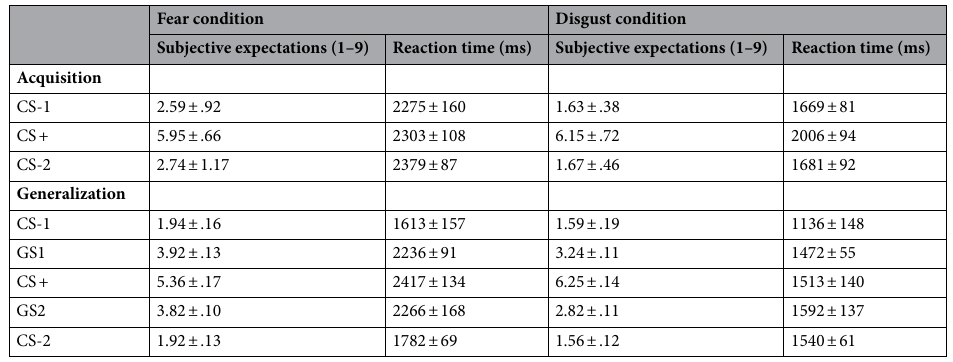
Table 1. The behavior results (M ±